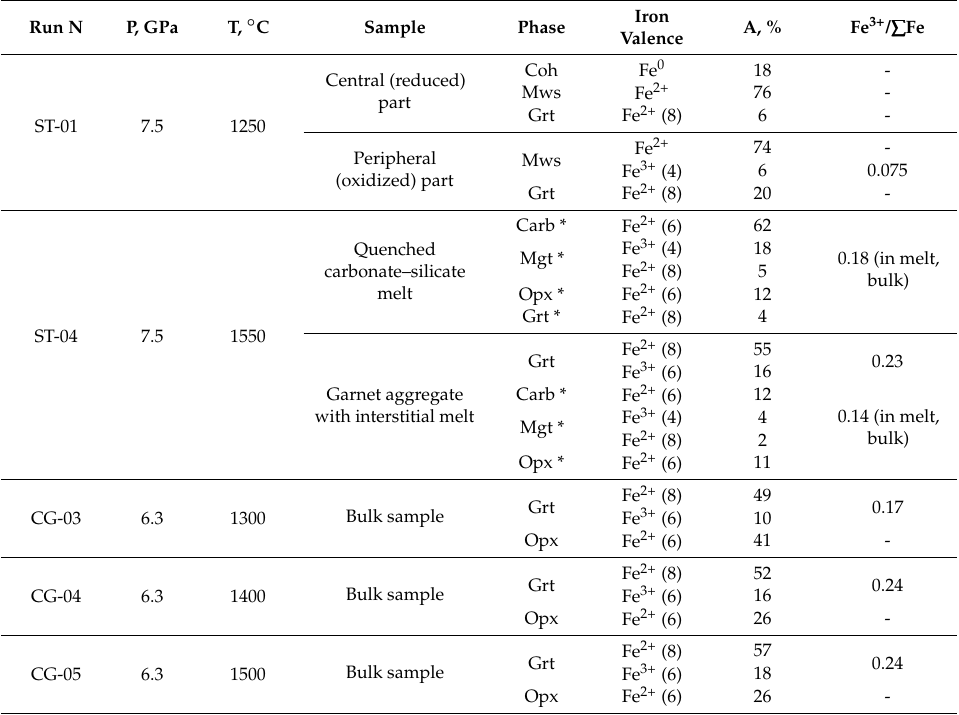
Table 5. 57 Fe Mössbauer data for silicates, carbonates, oxides and melts.